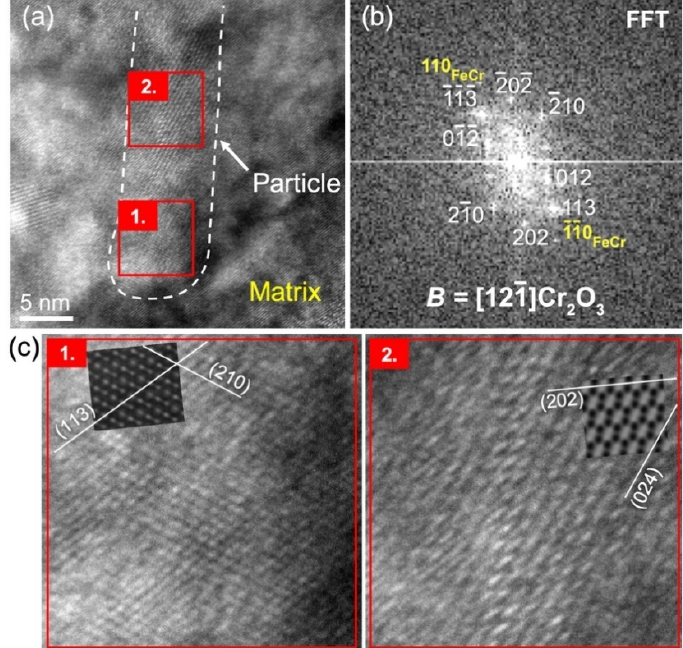
Figure 5. ( a ) HRTEM imaging of a precipitate with a corundum hexagonal Cr 2 O 3 structure showing two different patterns in regions defined by red squares, labelled 1 and 2. The FFT calculated in regions 1 and 2 is identical and reported in ( b ), together with the identified direction of observation of the precipitate with corresponding spot indexing. Enlargements of both regions 1 and 2, as well as simulated HRTEM patterns, are provided in ( c ), with similar magnification for accurate compar-